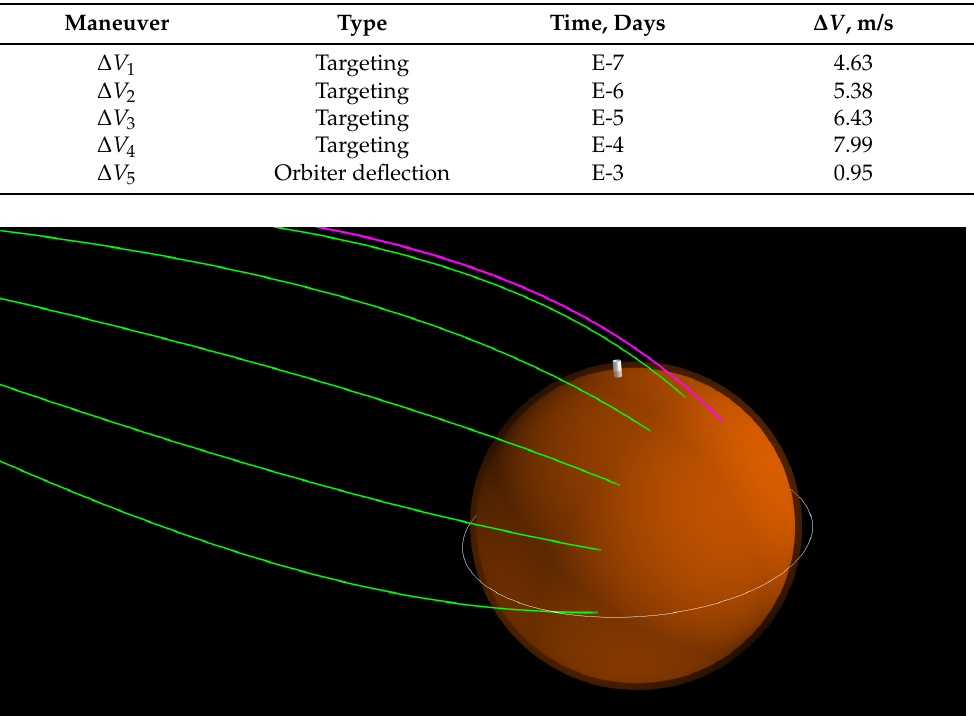
Table 13. Mars small satellite constellation targeting and orbiter deflection maneuvers.